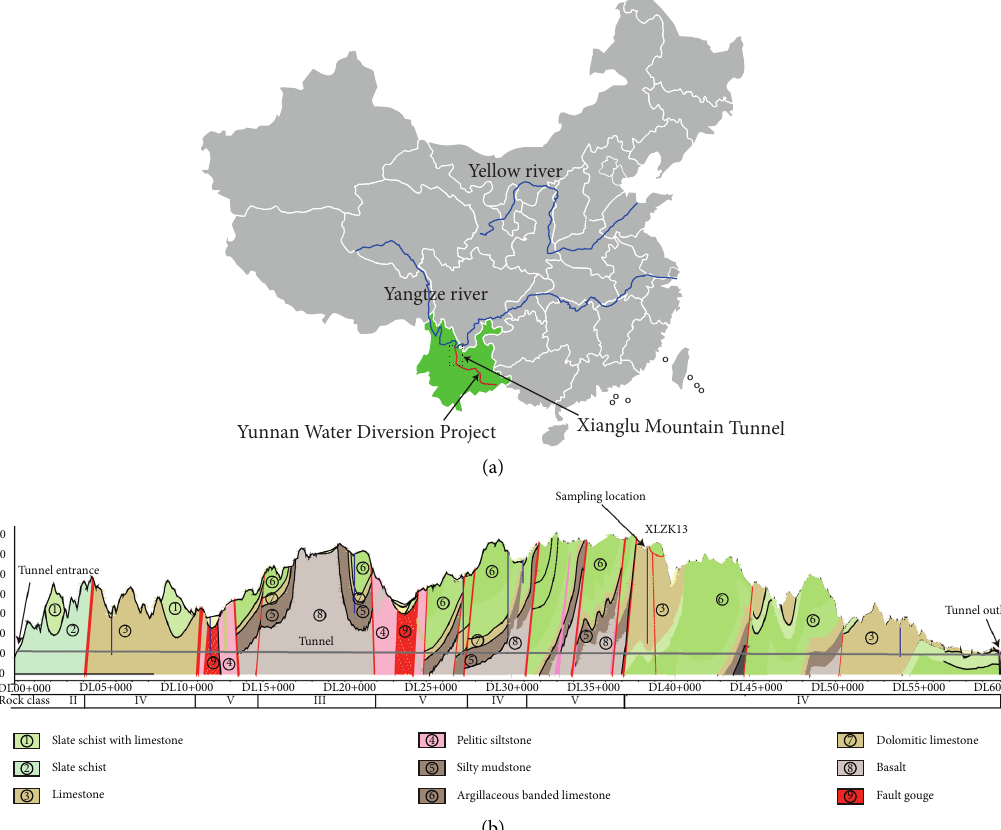
Figure 1: (a) Location of Yunnan Water Diversion Project and (b) geological profile of Xianglu Mountain Tunnel.